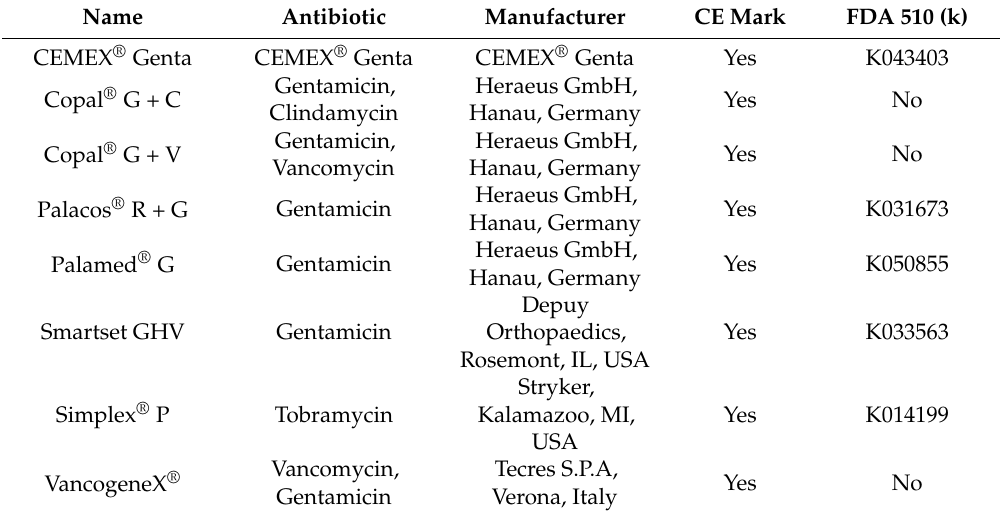
Table 1. Antibiotic-loaded PMMA